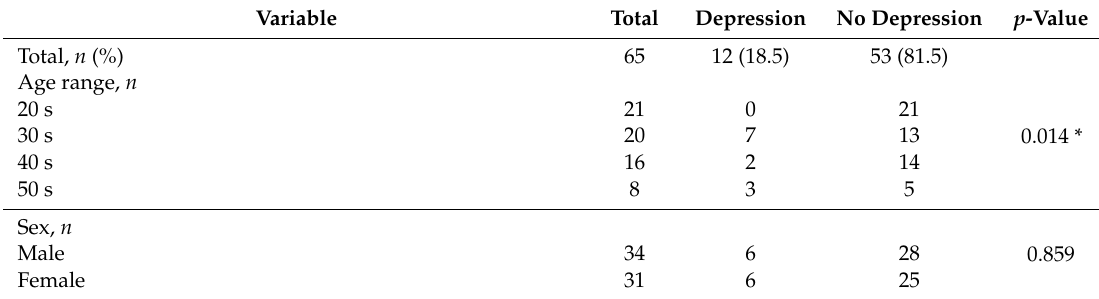
Table 2. Association of demographic data of physical therapists with COVID-19 and the presence of